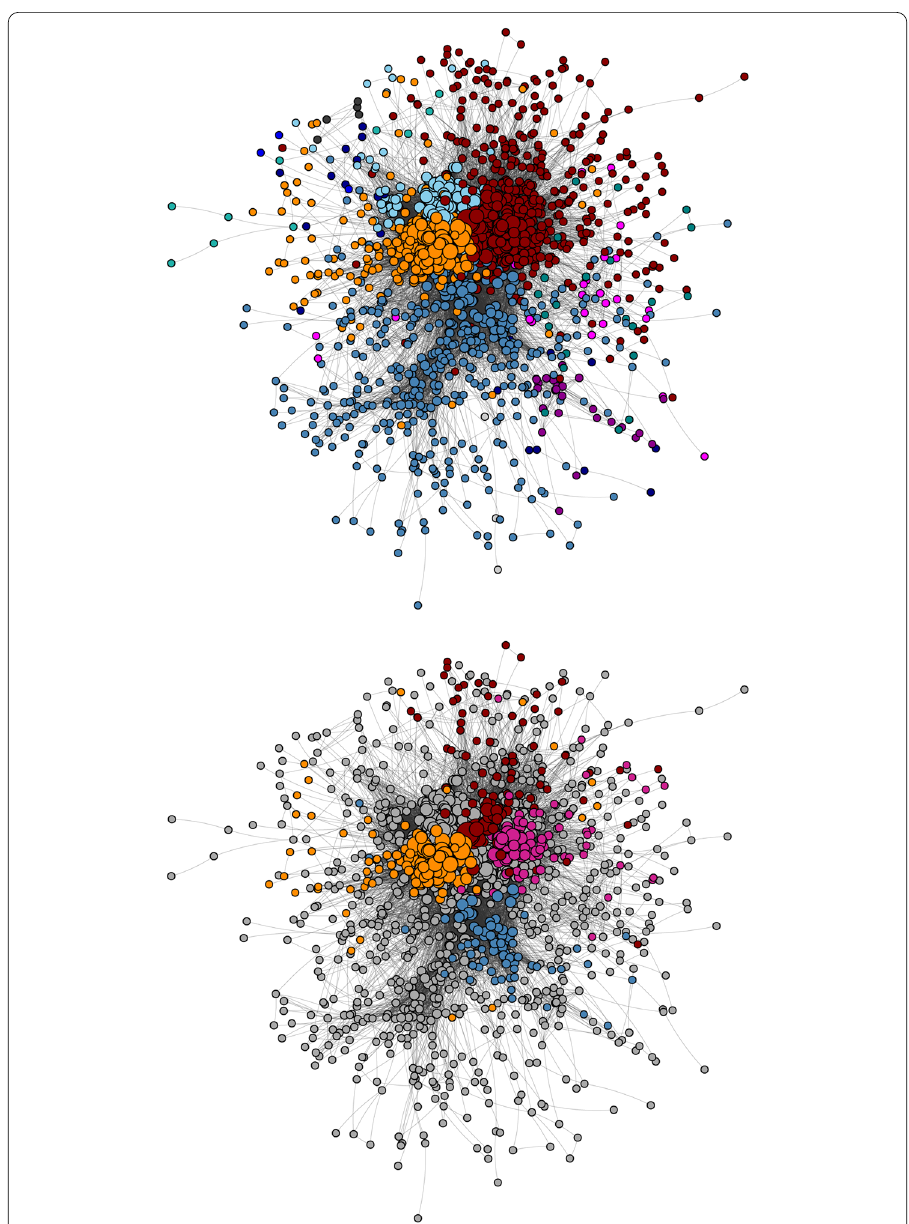
Figure 1 Discursive communities of verified users. They have been found running the Louvain community detection algorithm on the Largest Connected Component (LCC) of the validated network of verified users. Top panel: In red, top right corner, there are the center-left wing parties; in sky blue (on top), there are the official government accounts; in orange, the M5S-oriented community and in steel blue (on the bottom) the news media and center-right and right wing communities. Other minor communities can be found in the periphery of the LCC. Actually, by rerunning the same community detection algorithm inside these larger communities, it is possible to find purely political subcommunities, i.e., communities composed quite exclusively by politicians and official accounts of political parties. This can be seen in the lowest panel: in magenta, Italia Viva, the political party of the former Prime Minister Matteo Renzi; in red, the Partito Democratico, i.e., the Italian Democratic Party; in orange, M5S and in blue the center-right and right wing parties Forza Italia, Lega and Fratelli d’Italia. A more detailed description of the subcommunities of the network can be found in Sect. 2 of the Additional file 1. In both panels, the node dimensions are proportional to their degree. The layout used for network visualization is the Fruchterman-Reingold one